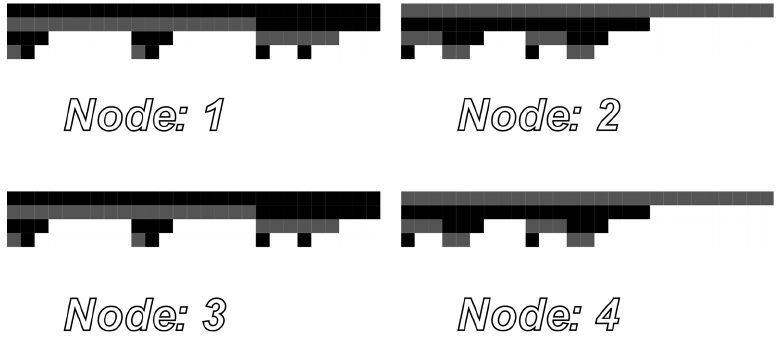
Figure 2. Image bitmaps generated from four vertices of the simple graph presented in Figure 1.